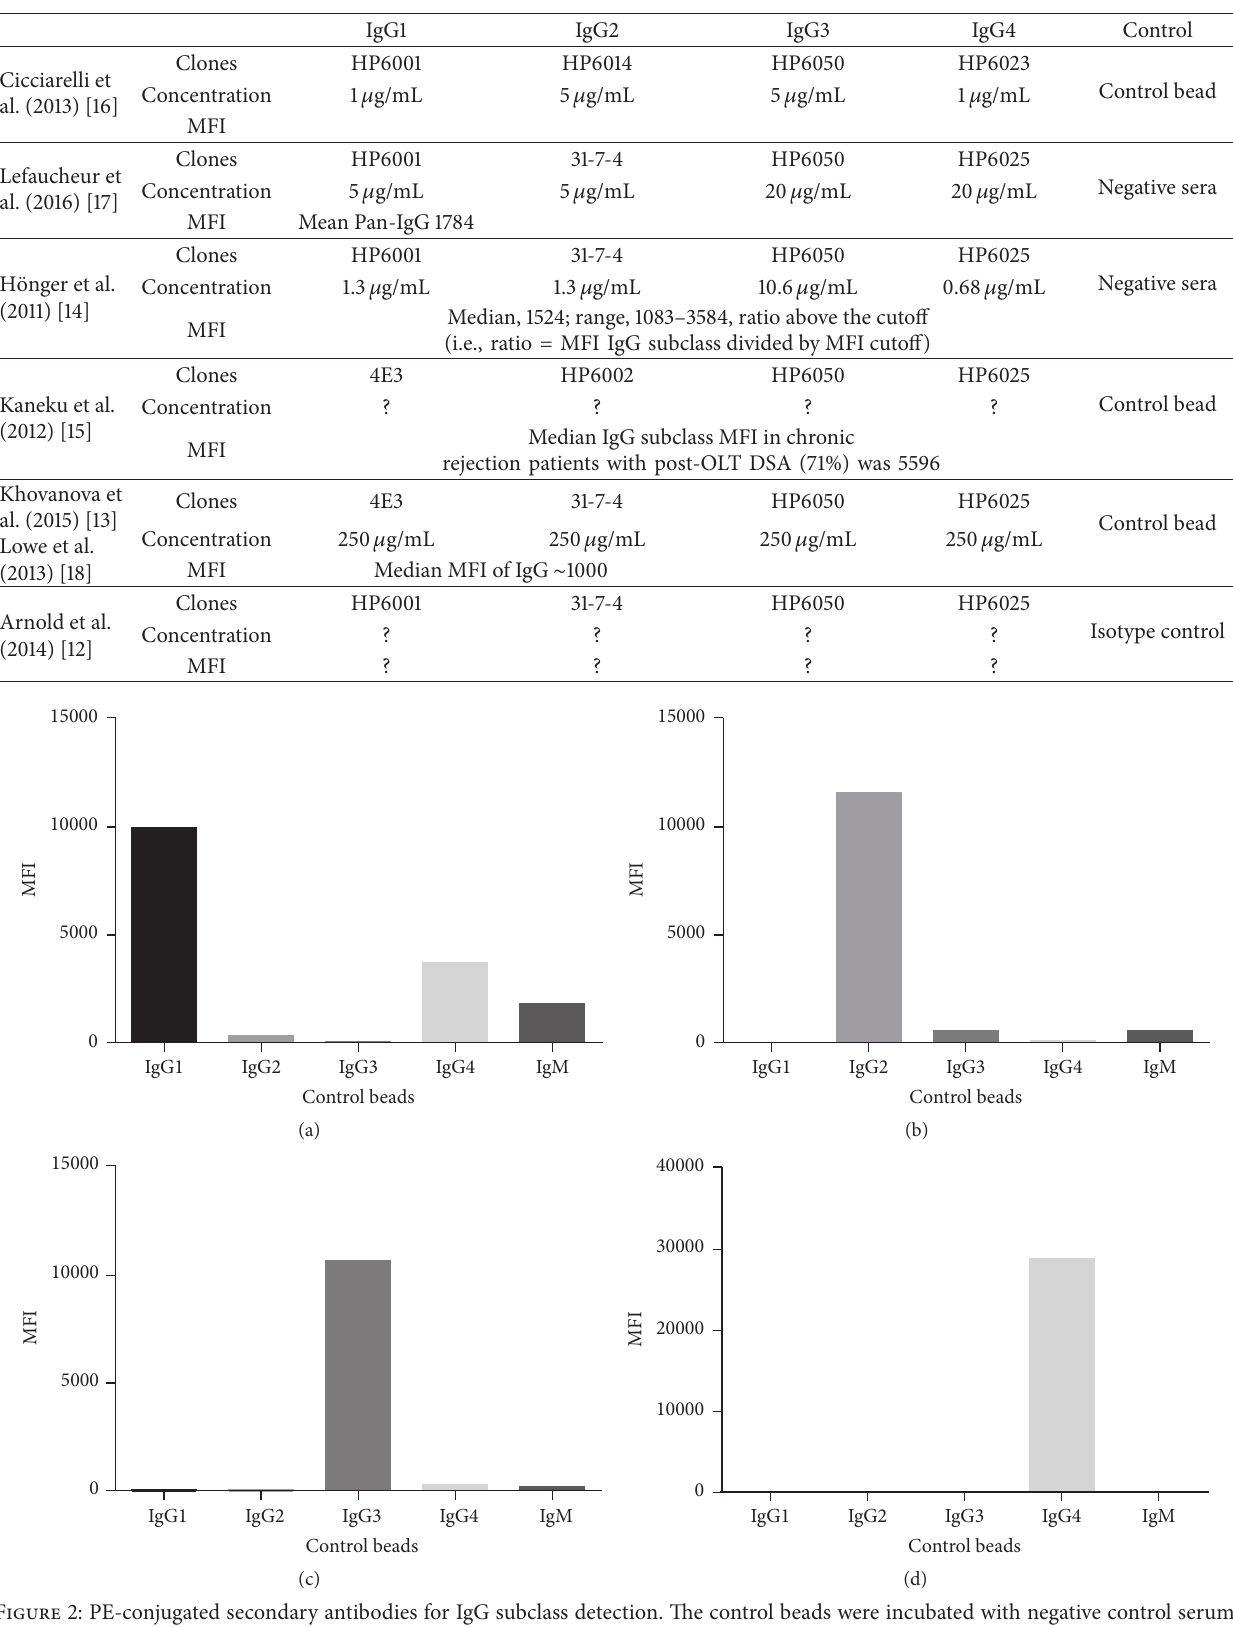
Table 3: Reported IgG subclass antibodies used for DSA detection.